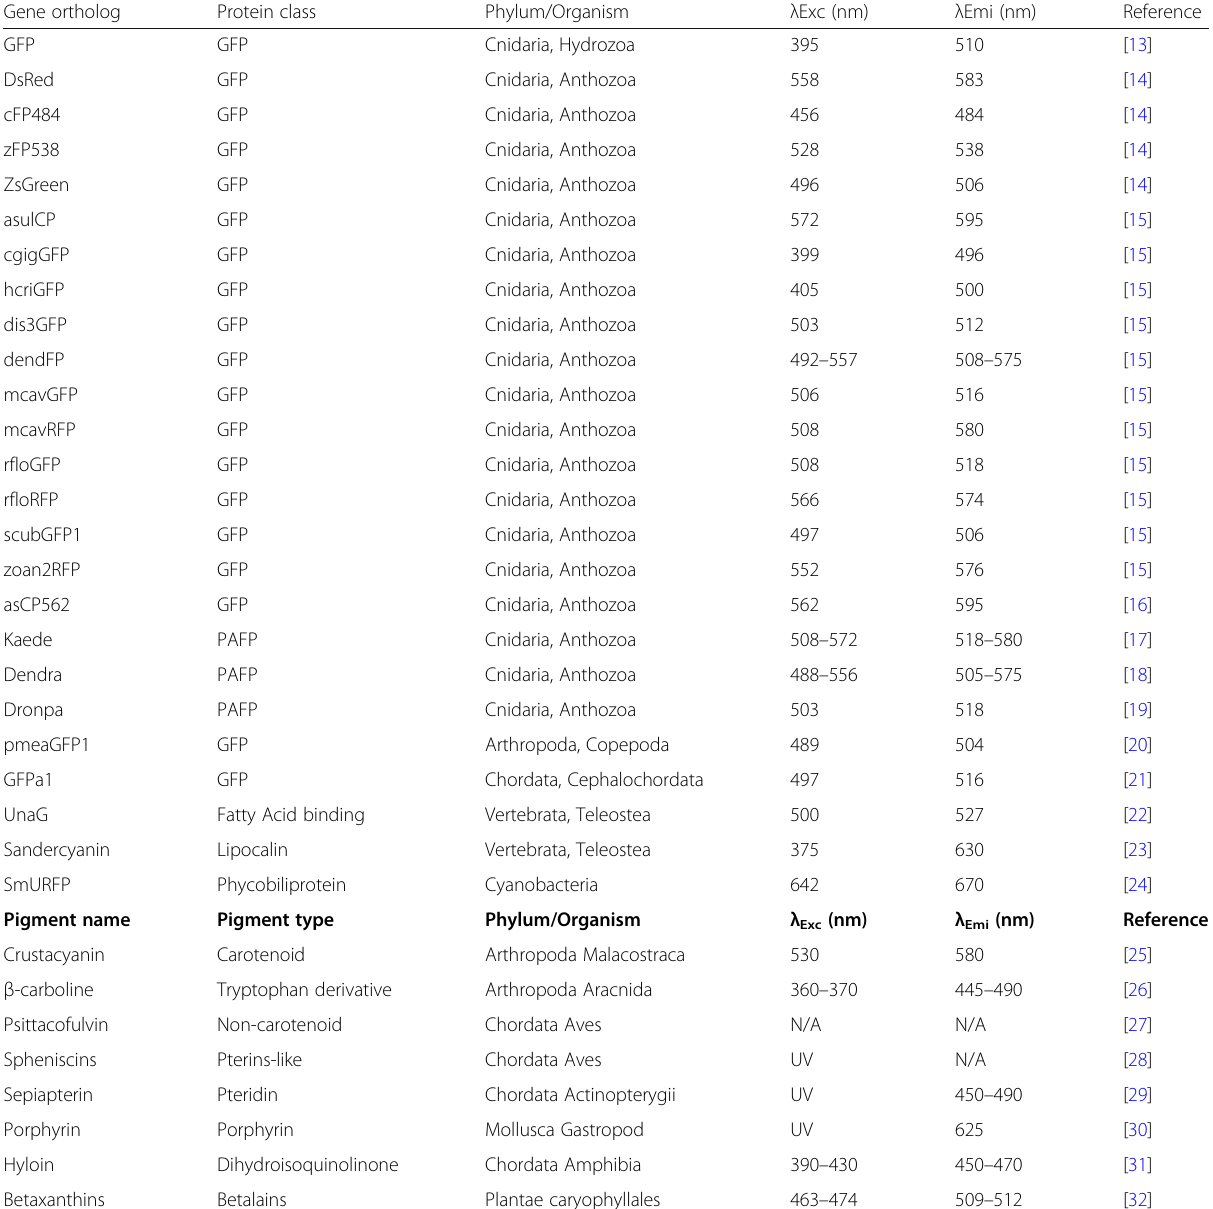
Table 2 Natural and photoactivable fluorescent proteins and pigments Gene ortholog Protein